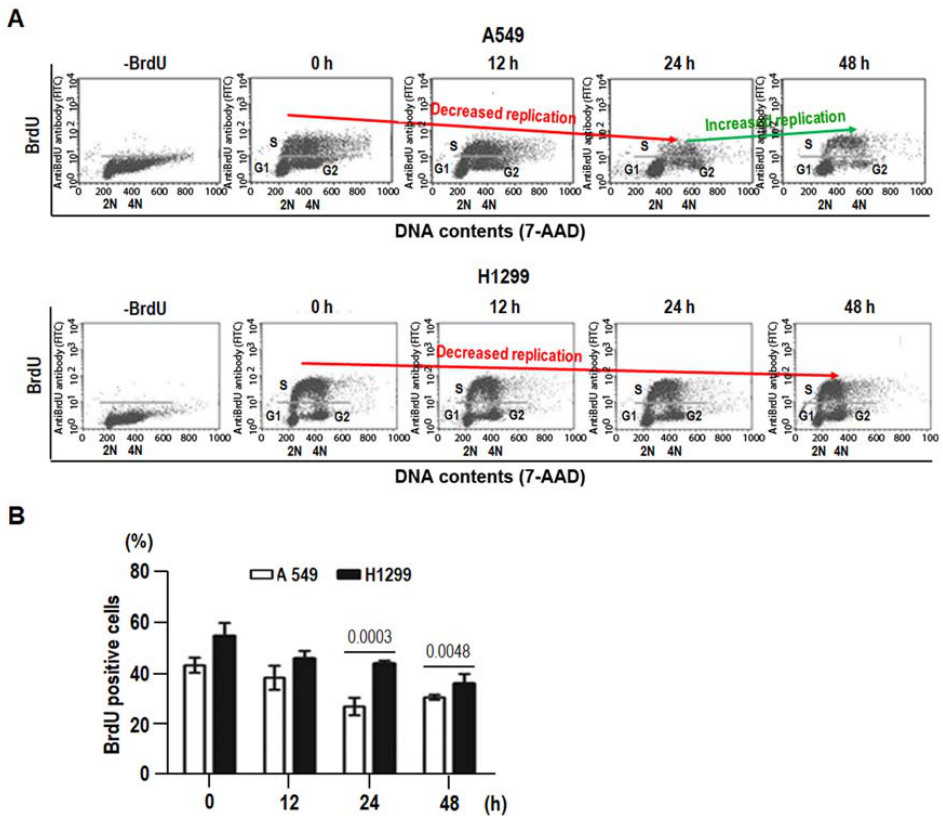
Figure 6. BrdU incorporation into 8-Cl-Ado-exposed A549 and H1299. After exposed to 2 μ M 8-Cl-Ado for indicated hours, cells were pulsed with BrdU prior to harvest. After DNase treatment, cells were stained with fluorescein isothiocyanate (FITC)-conjugated anti-BrdU antibody, followed by flow cytometry with FACS Diva software (BD Biosciences, San Jose, CA, USA). ( A ) A representative flow cytometry analysis of BrdU-positive cells. S, G1 (2N) and G2/M (4N) cells are indicated; ( B ) histograms showing the percentage of BrdU-positive S cells in flow cytometry experiments. Data represent mean ± SD ( n = 3).